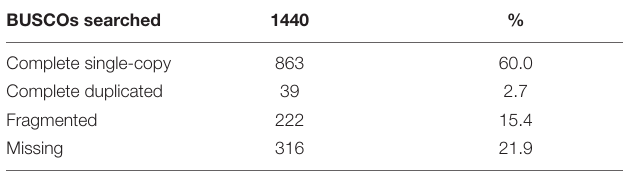
TABLE 3 | Assessment of Illumina- and PacBio-based assemblies using the BUSCO core gene set. (a) De novo genome assembly using